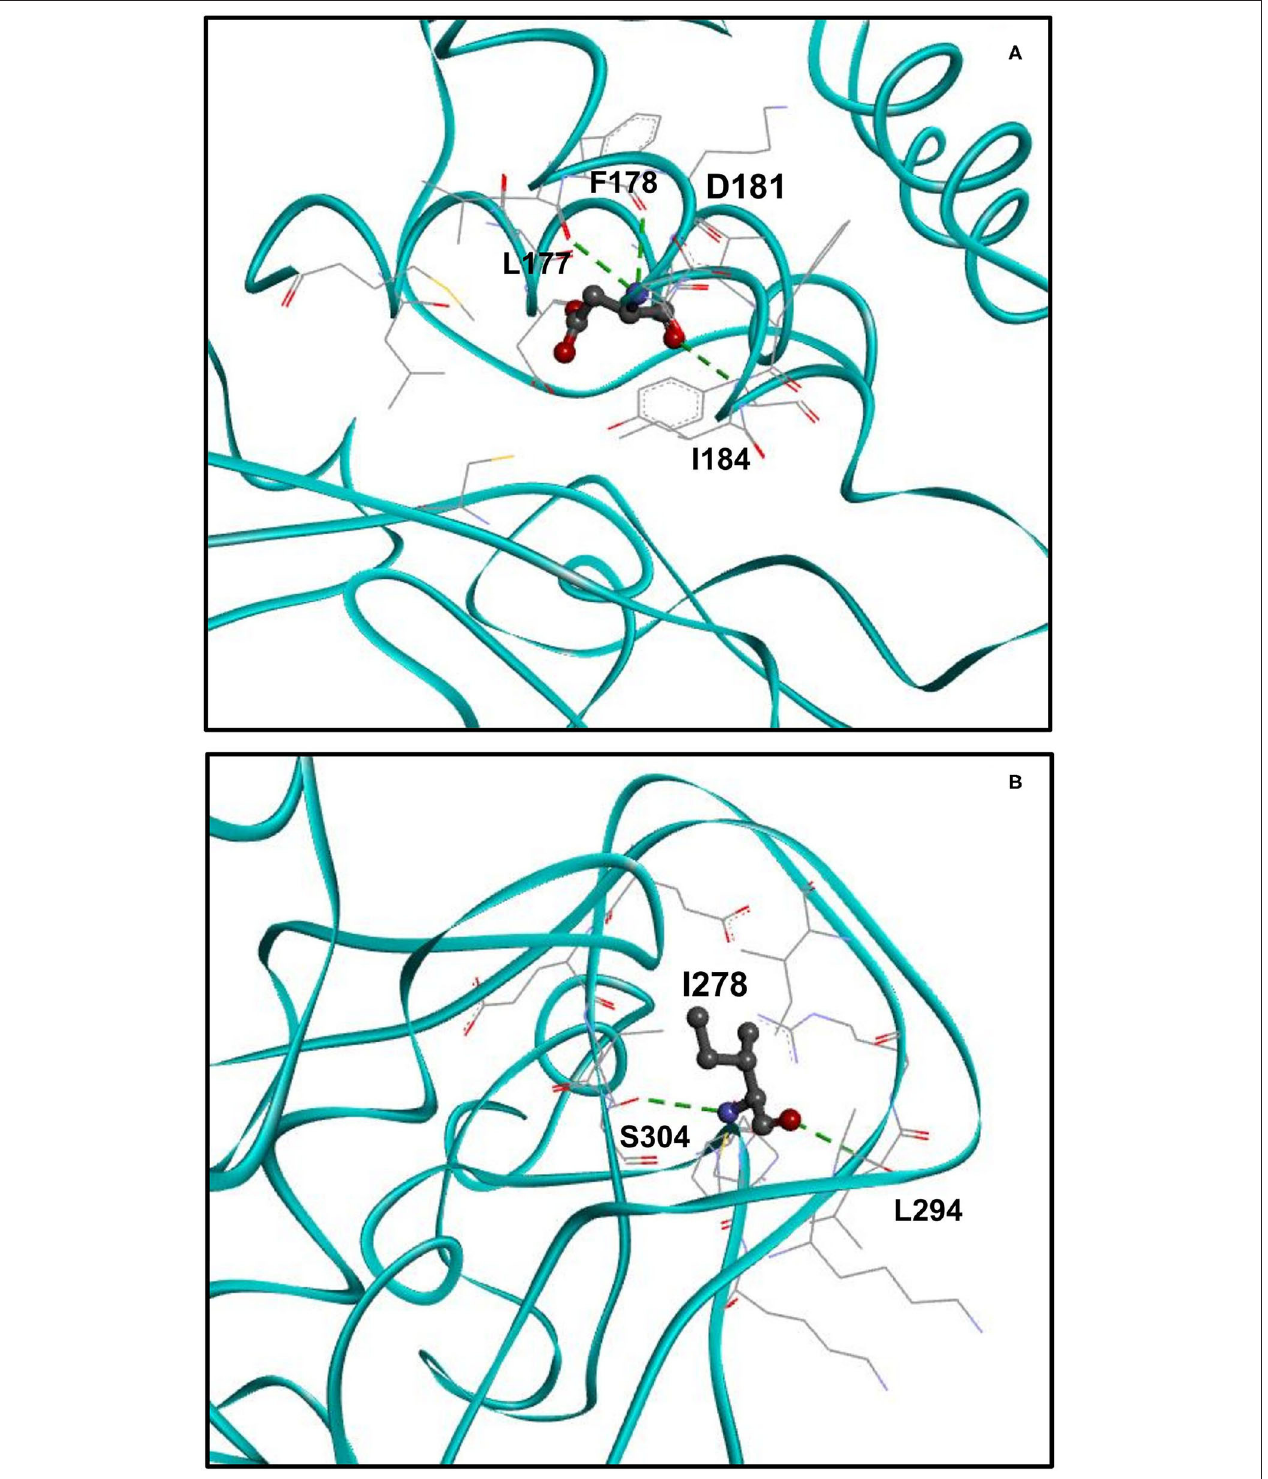
FIGURE 3 | Structure of H181D and N278I mutants. (A) Close up view on the structure of H181D mutant. KMT5B is in cyan. Residue D181 is shown in ball and stick by charge and the residues with which hydrogen bonds are formed, shown in dashed green, are presented in stick. According to the model, hydrogen bonds are formed between D181 and L177, F178 and I184. (B) Close up view on the structure of N278I mutant. Residue I278 is shown in ball and stick by charge and the residues with which hydrogen bonds are formed, shown in dashed green, are presented in stick. Two hydrogen bonds are formed between I278 and S304 and a single hydrogen bond is formed with